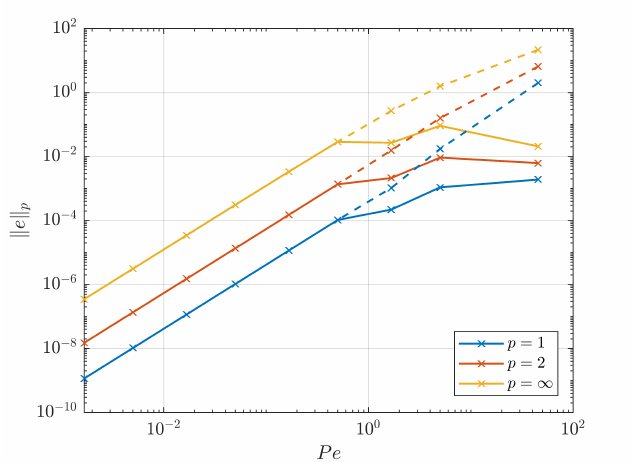
Figure 3. Figure showing the dependence error on the Peclet number, as measured in three different norms. The dashed lines show the performance of the old scheme and the full lines show the performance of the new